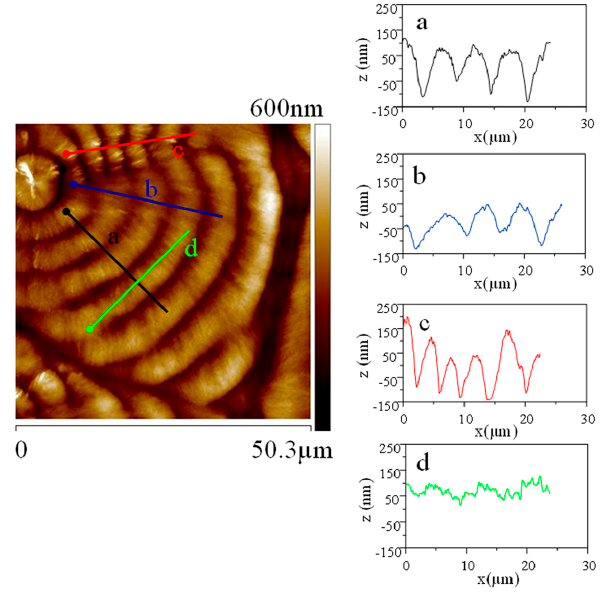
Figure 4. AFM height image ( left ) and profiles along the lines ( a – d ) showing regular bands with localized dislocations. Film thickness = 1.5–2.0 µm. AFM image is reproduced with permission from dislocations. Film thickness = 1.5–2.0 µ m. AFM image is reproduced with permission from ref. ref. [6].